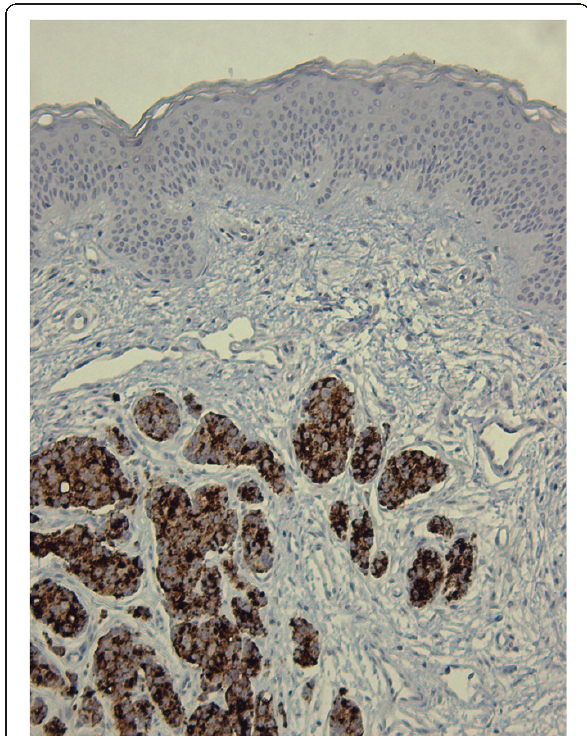
Figure 5 Dermal clusters of malignant cells positive for PSA. The above epidermis reveals no PSA positive neoplastic cells.